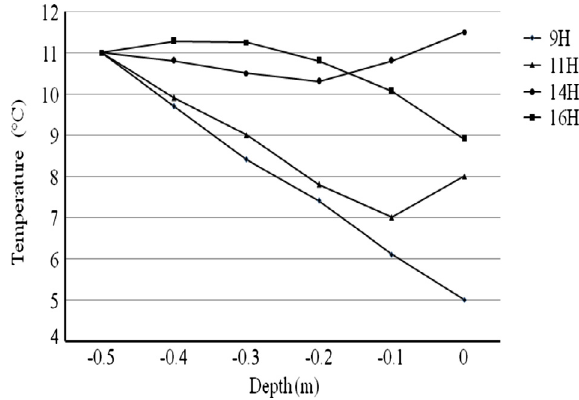
Figure 11. Temperature evolution in terms of depth (January 15).